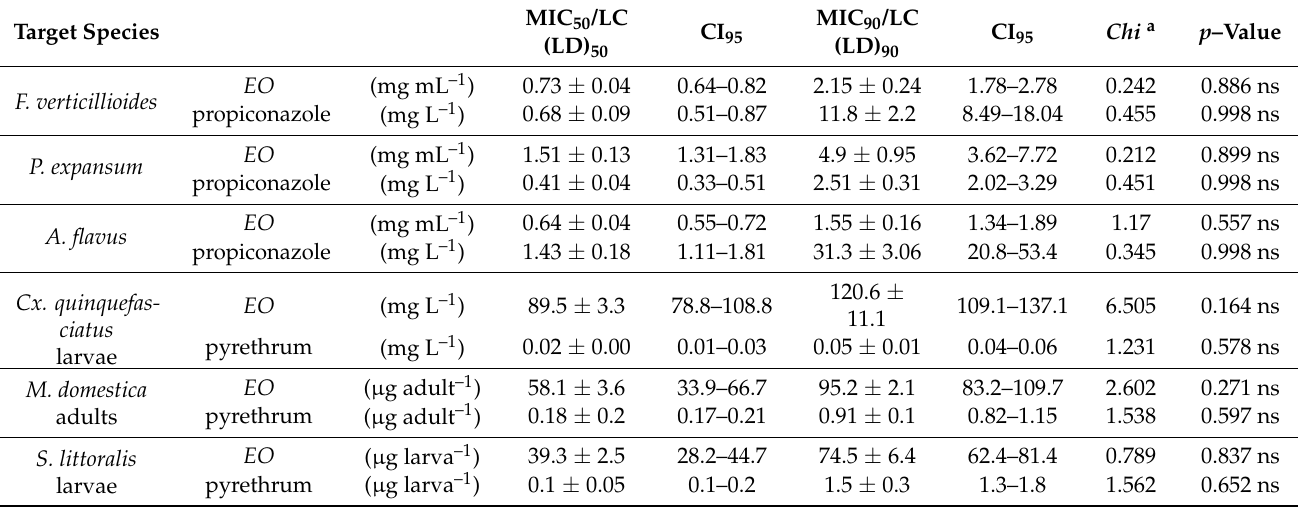
Table 2. Antifungal and insecticidal activity of the essential oil from the Ocimum sanctum against target species. Target